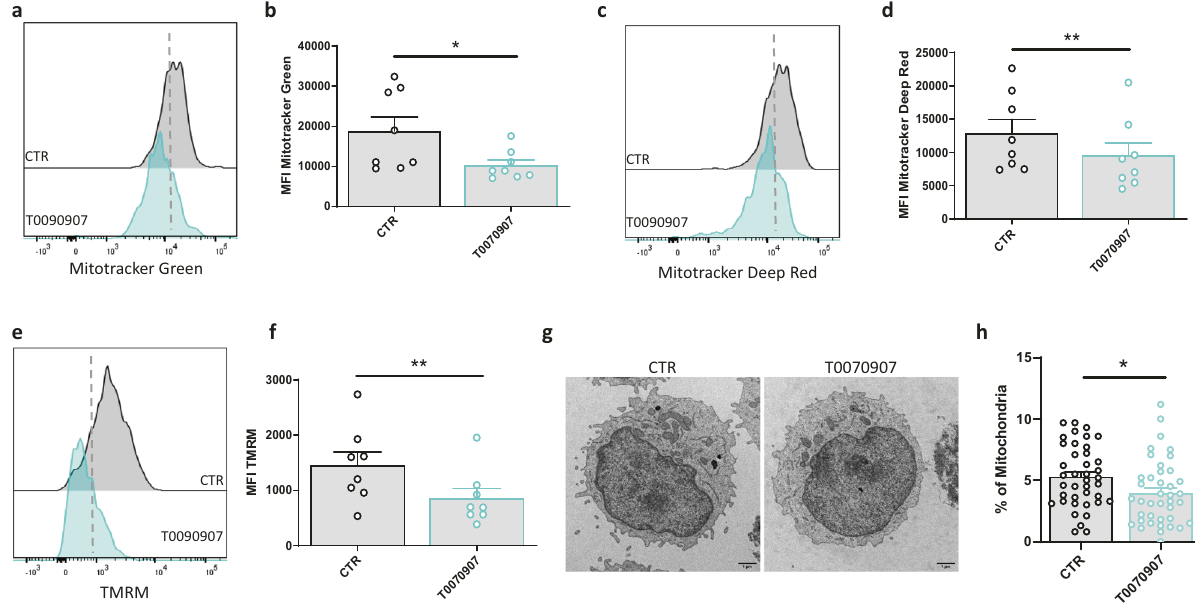
Fig. 3 PPAR γ inhibition in ILC2s results in mitochondrial dysfunction. a , c , e Representative examples of fl ow cytometry analysis of MitoTracker Green ( a ) MitoTracker Deep-red ( c ) and TMRM ( e ) in ILC2s untreated (gray histograms) and after T0070907 treatment (blue histograms) for 48 h, with their respective quanti fi cation in terms of mean fl uorescence intensity (MFI), in b , d , f ILC2s untreated (open circle) and after T0070907 treatment (open aqua circle), ( n = 8; Mitotracker Green * P = 0.0282, Mitotracker Deep Red ** P = 0.0019, TMRM ** P = 0.0036). Representative electron microscopy images (×4800 magni fi cation; scale bars: 1 µ m) ( g ) and quantitative plots ( h ) of mitochondrial volume in ILC2s untreated (open circle) and after T0070907 treatment (open aqua circle) for 48 h ( n = 40 cells examined for each experimental condition over one independent experiment; * P = 0.0307). Each symbol represents one individual donor or one cell. Data are shown as mean ± SEM and were analyzed by two-tailed Wilcoxon tests. Source data are provided as a Source data fi